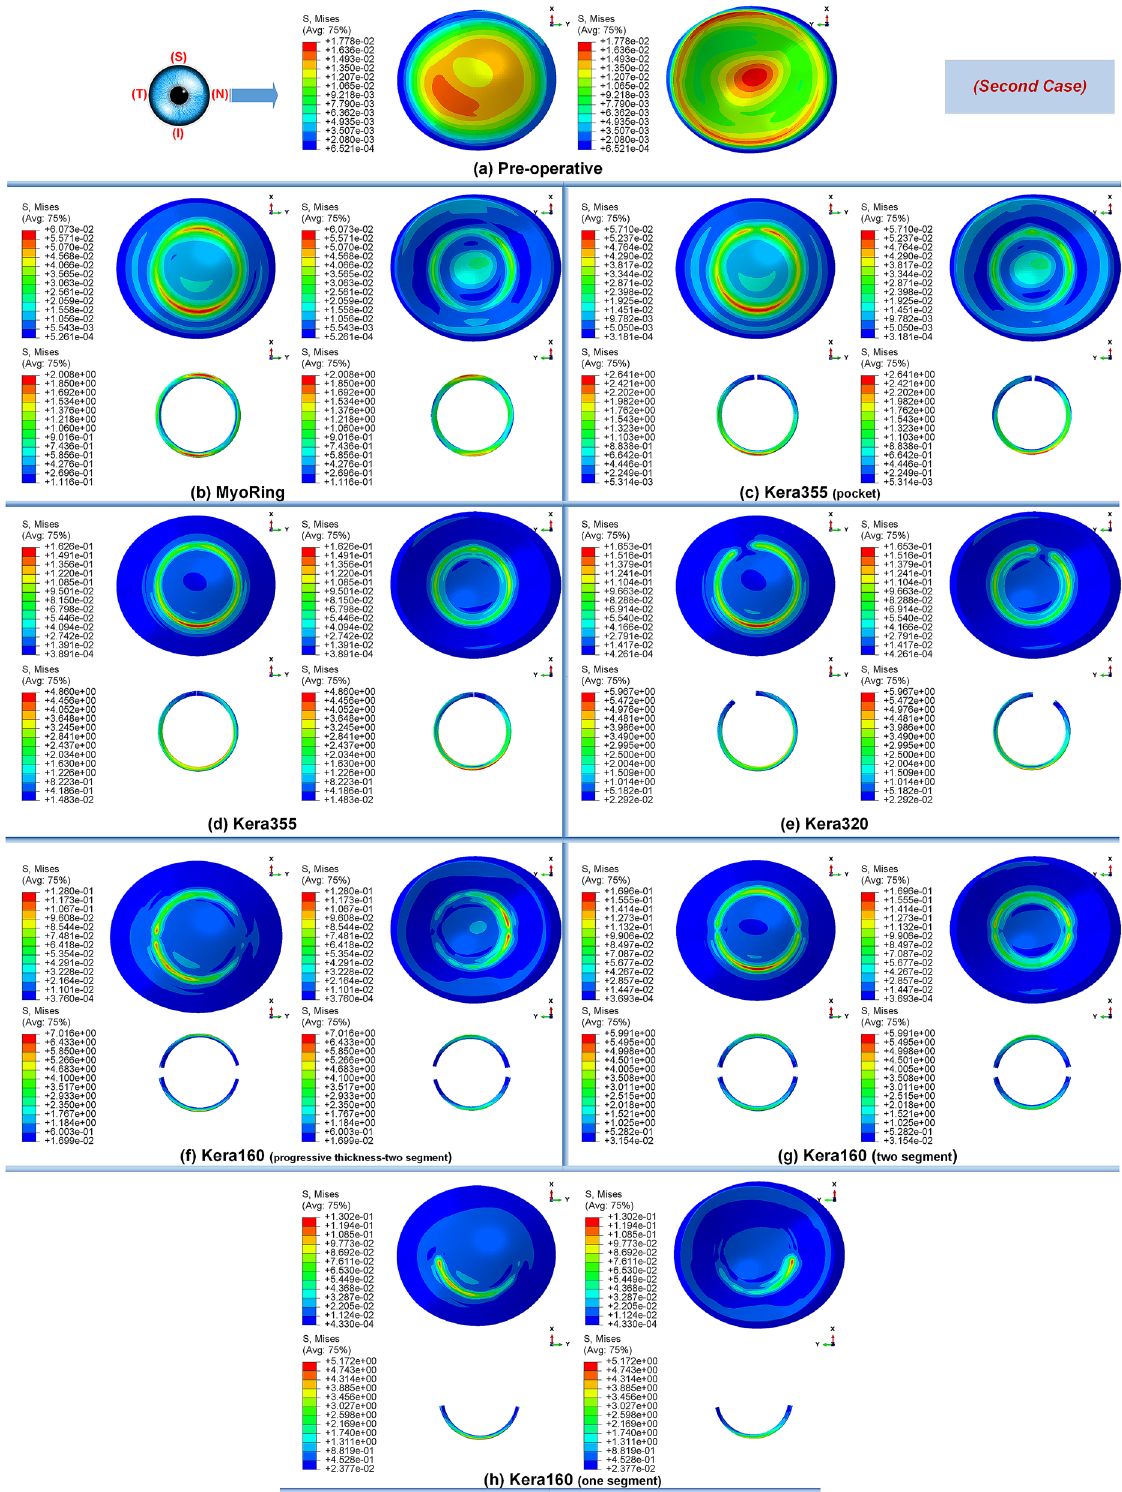
Figure 12. The pre- and post-operative contour diagrams of the Von Mises stress distribution (MPa) in FEM of different surgical scenarios (second case): ( a ) preoperative; ( b ) MyoRing; ( c ) Kera355 implemented by pocket incision; ( d ) Kera355; ( e ) Kera320; ( f ) Kera160-two prog segments; ( g ) Kera160-two segments; ( h ) Kera160-one prog